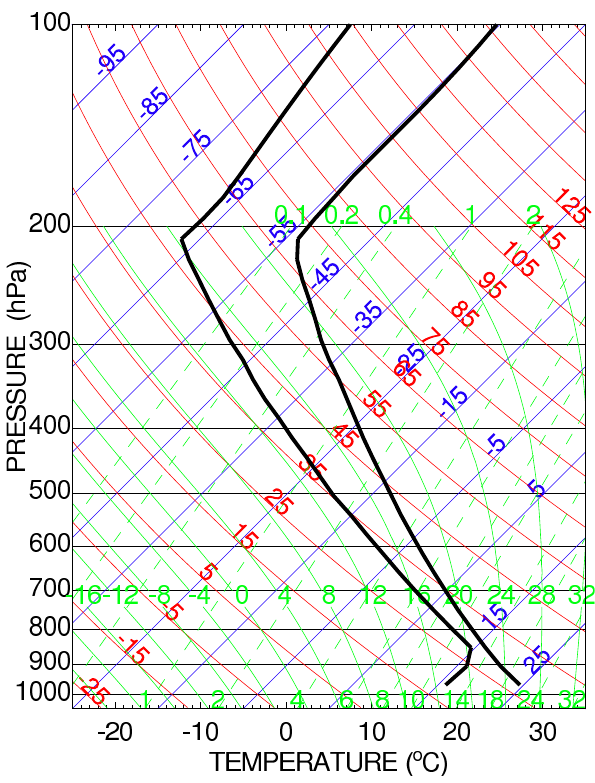
Fig. 1. Skew-T diagram of the initial environmental sounding.